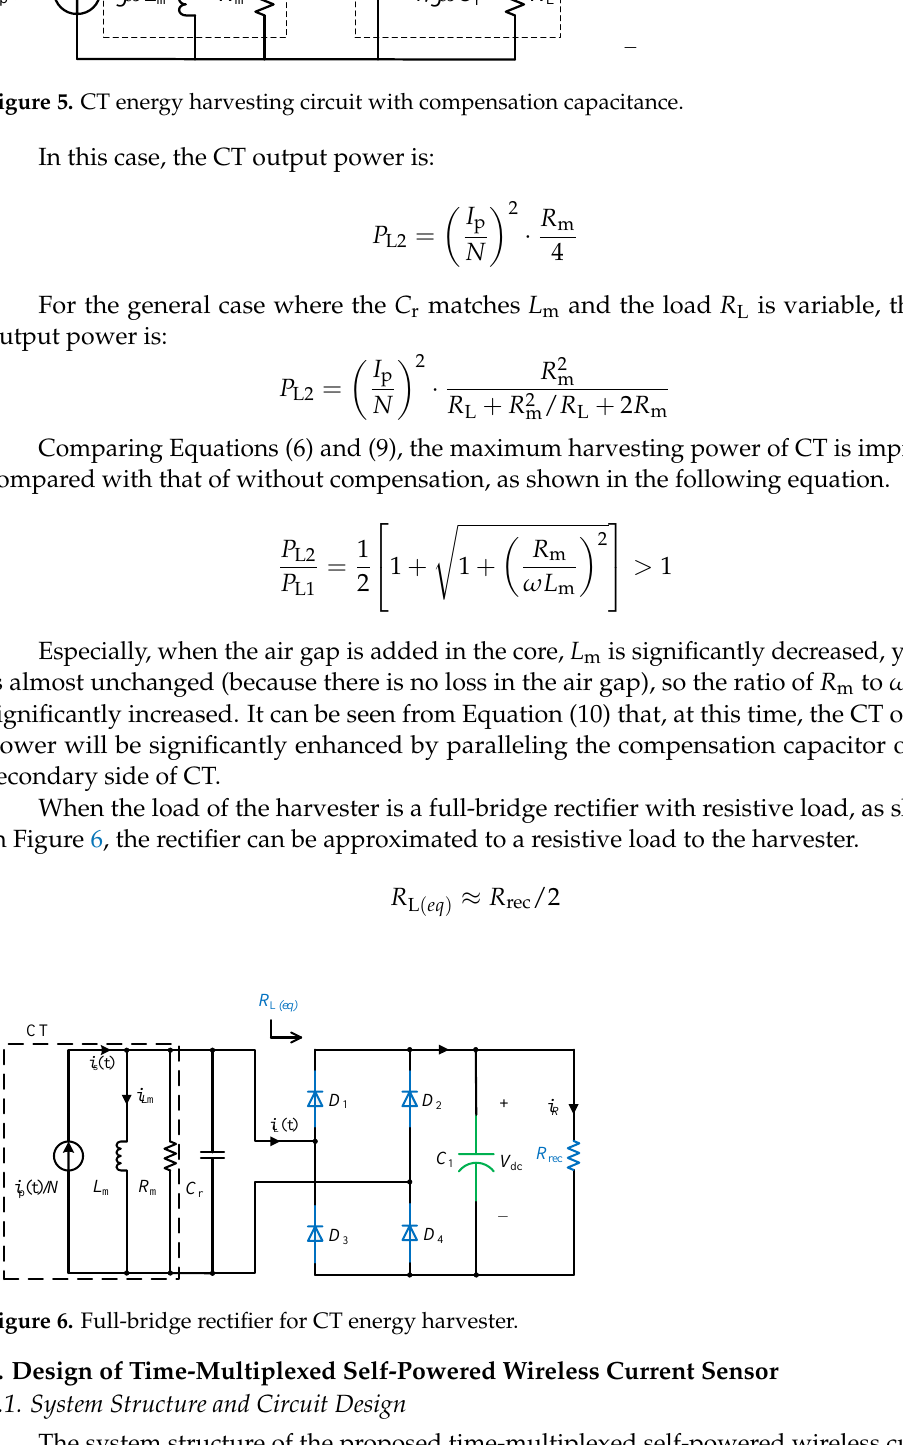
Figure 6. Full-bridge rectifier for CT energy harvester.